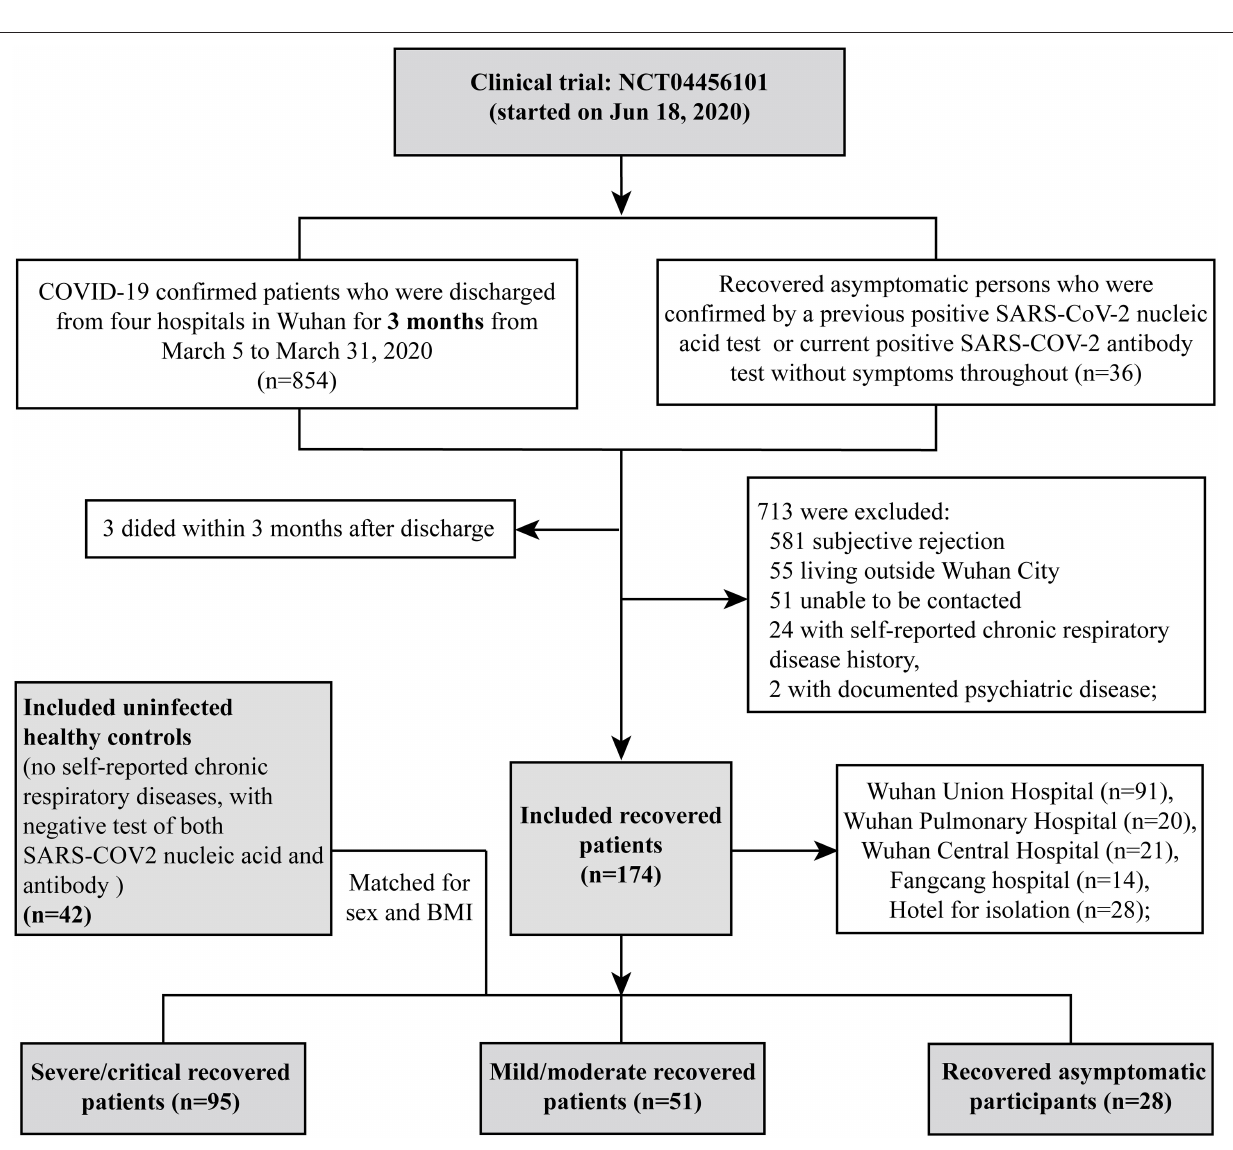
FIGURE 1 | Flowchart of participant